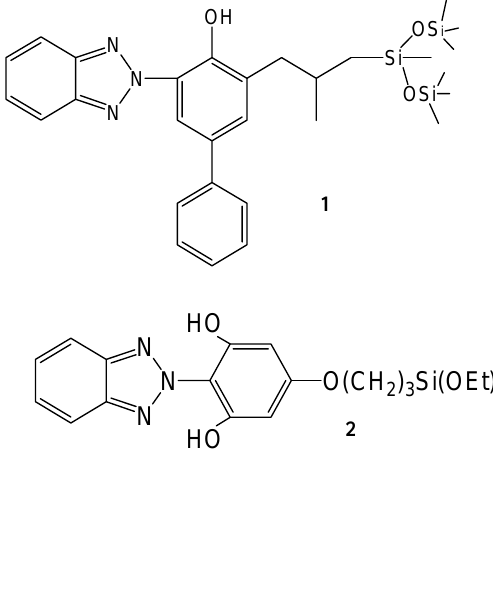
Figure 1. Compounds prepared and